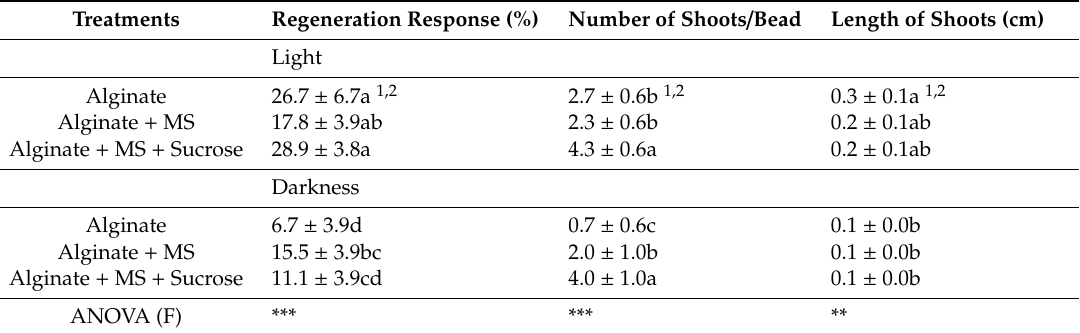
Table 2. Influence of inclusion of MS nutrient medium and sucrose (1%) in the encapsulation matrix (with 2.5% sodium alginate and 50-mM calcium chloride) on artificial seed germination of V. dentatum , in darkness or under